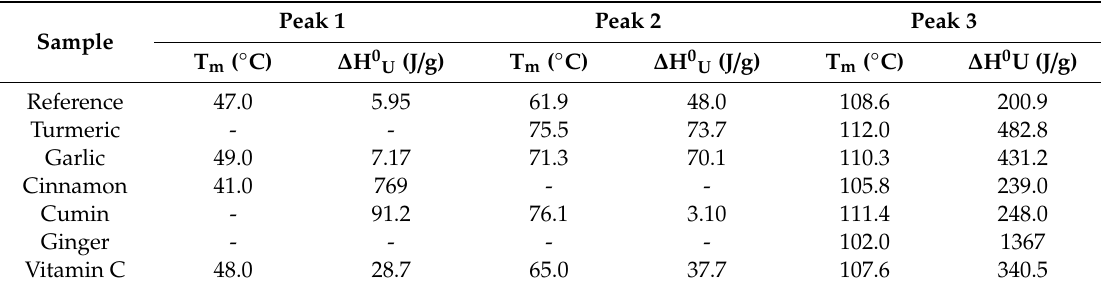
Table 1. Transition temperature, T m ( ◦ C), and enthalpy ∆ H 0 (J / g) for antioxidant treated and